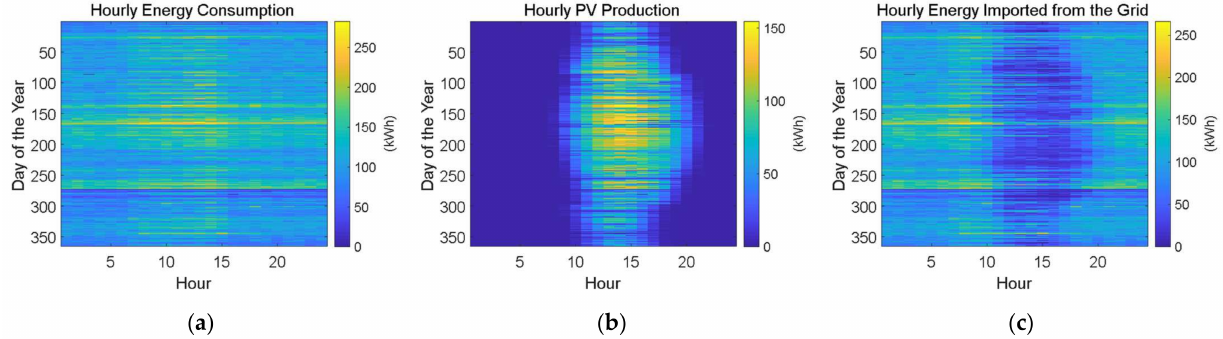
Figure 13. Heatmaps of hourly values for the industrial PVSCS ( a ) Electricity consumption ( b ) PV production ( c ) Energy imported from the